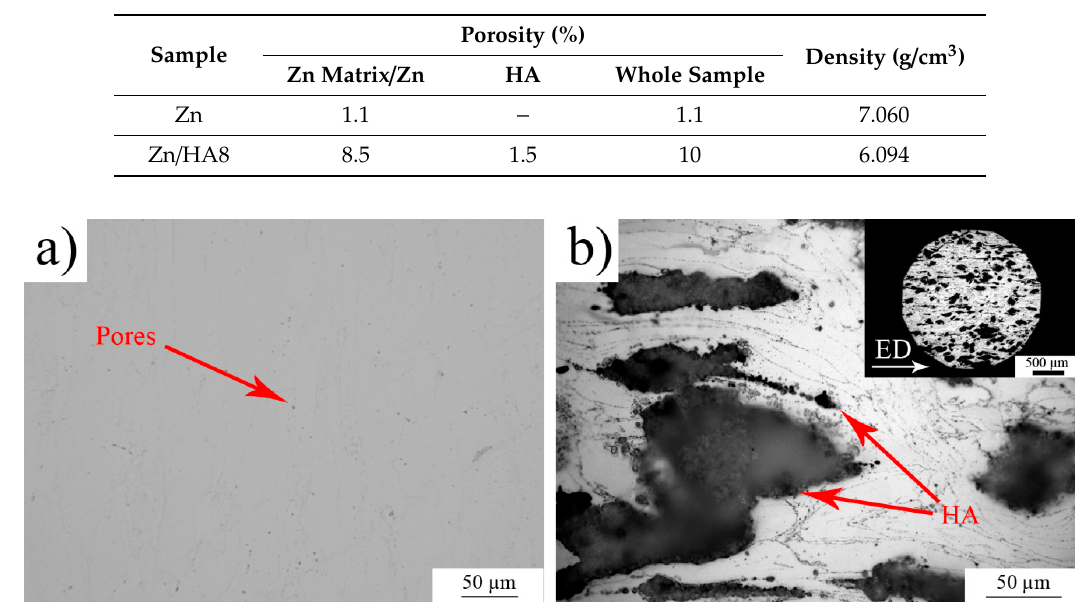
Figure 2. Micrographs of ( a ) pure zinc and ( b ) Zn/HA8 composite structures.